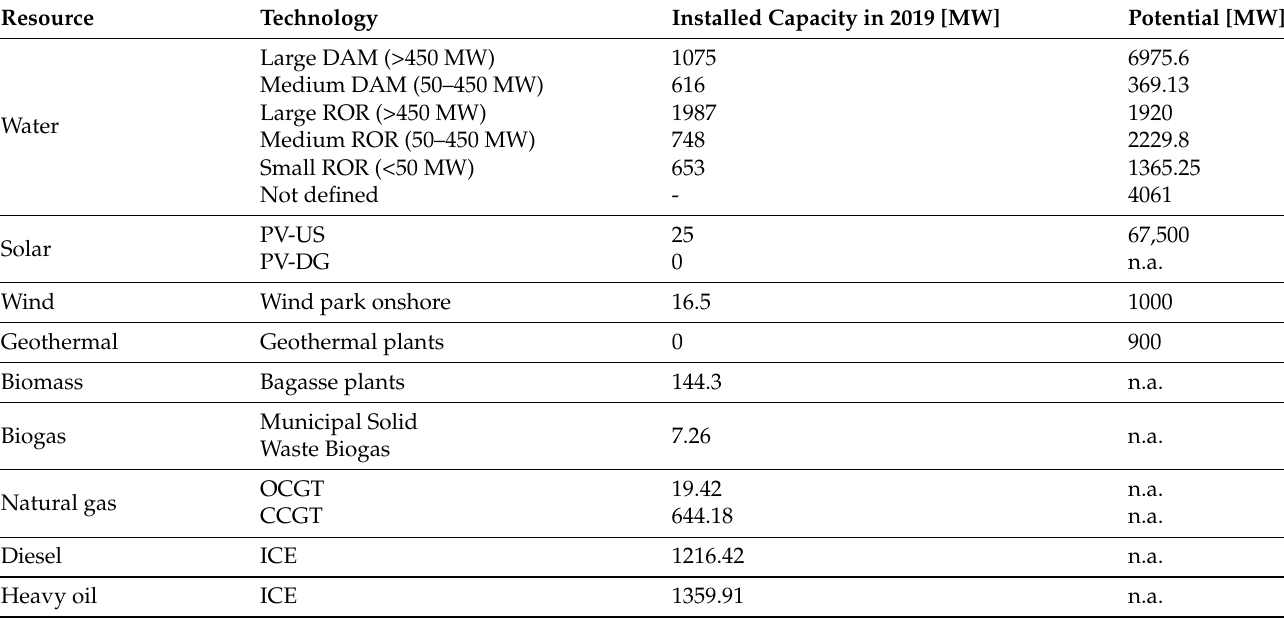
Figure 4. Power plants location by 2019 and by 2027 [55,56]. Table 2. Type of technology, installed capacity, and resource potential included in urbs